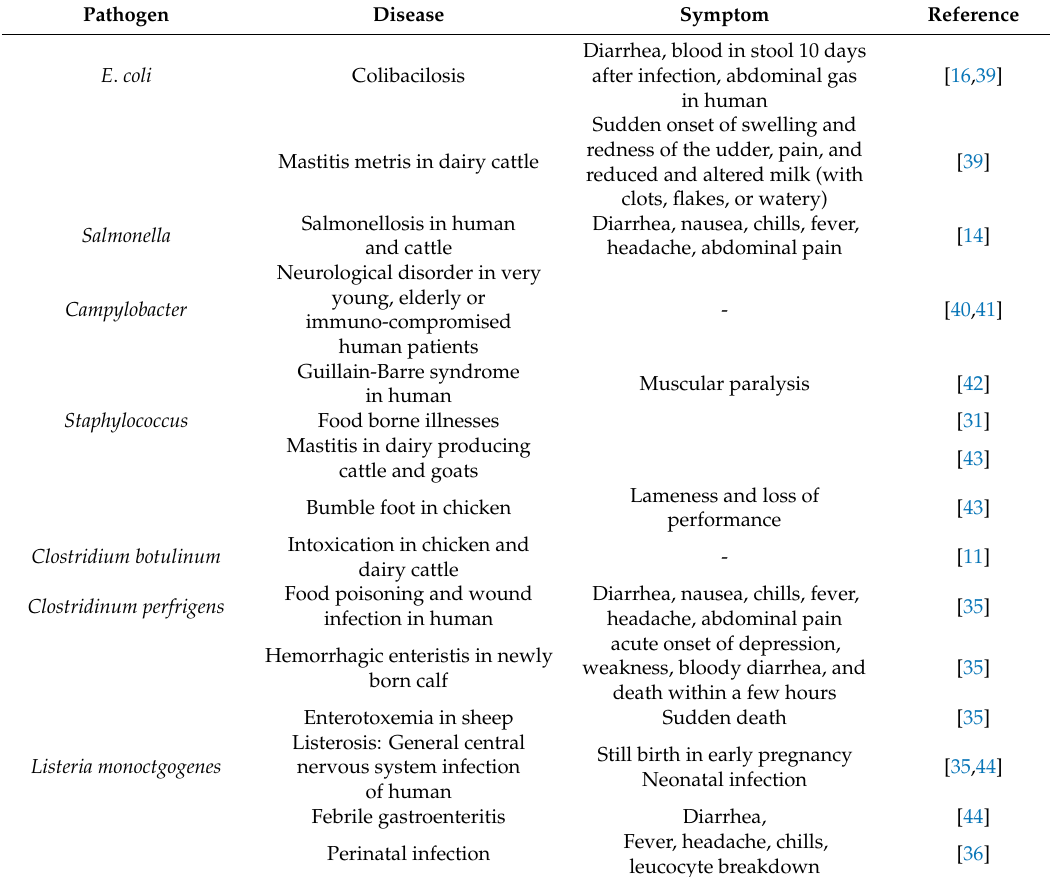
Table 2. Bacterial pathogens in chicken litter and their health e ff